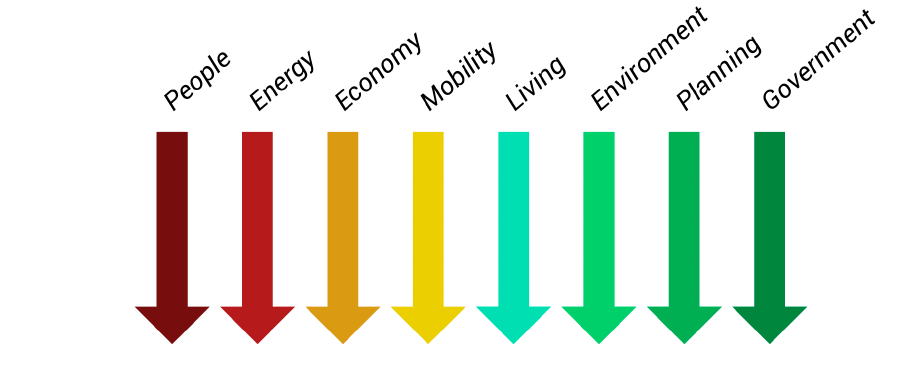
Figure 2. Vertical dimension of a Smart city.